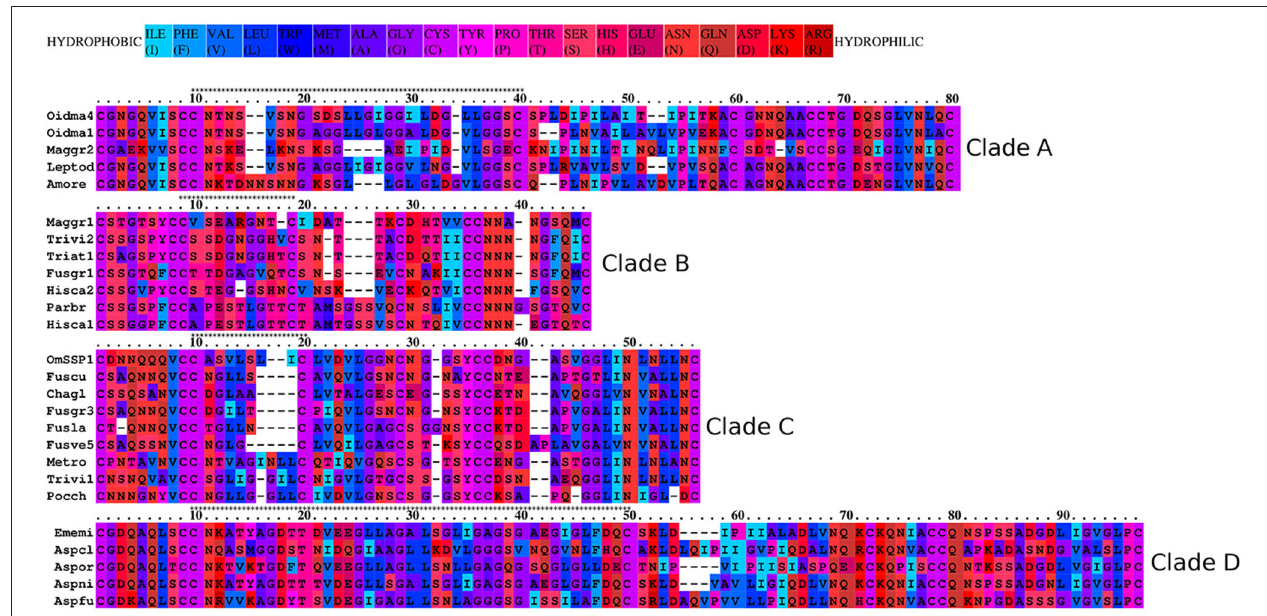
FIGURE 4 | Aminoacid hydrophobicity properties of the aligned Class I hydrophobins. The OmSSP1 and hydrophobin protein sequences belonging to the four clades (A–D) in Figure 3 were aligned with the Praline tool of the IBIVU server (http://www.ibi.vu.nl/programs/pralinewww/; Simossis et al., 2005). The hydrophobicity scale used is from Eisenberg et al. (1984). The C3-C4 loop is indicated above each clade alignment by a string of asterisks.